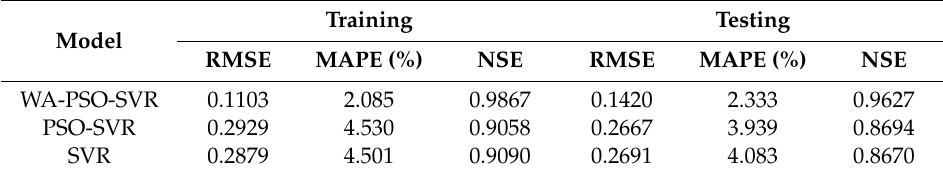
Table 2. Statistical values of daily COD Mn prediction in the training and testing phase.